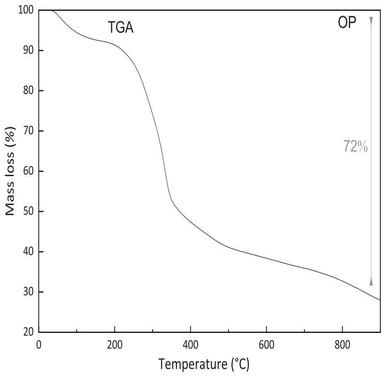
TGA patterns of raw OP.